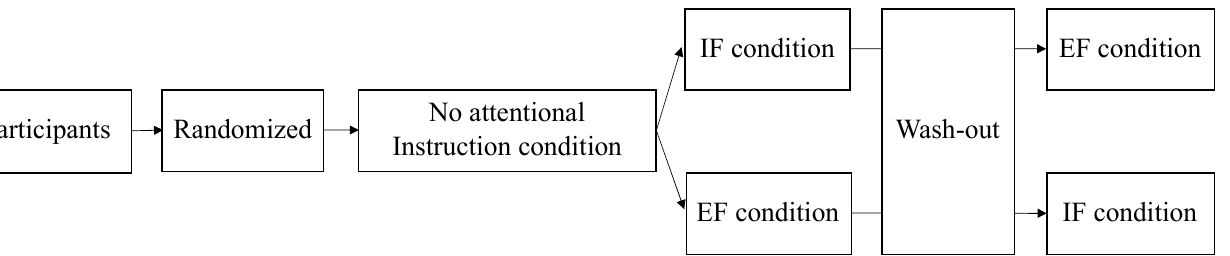
Figure 1. At first, the participants performed the task in the “no attentional instruction” condition without attentional focus. The participants were randomly divided into two groups. One group performed the IF condition followed by the EF condition, and the other group performed the EF condition followed by the IF condition. The participants performed a washout task with no attention focus in between the attention-focused tasks. Attention was focused on the inside and outside of the body in the IF and EF conditions, respectively. IF: internal focus; EF: external focus.